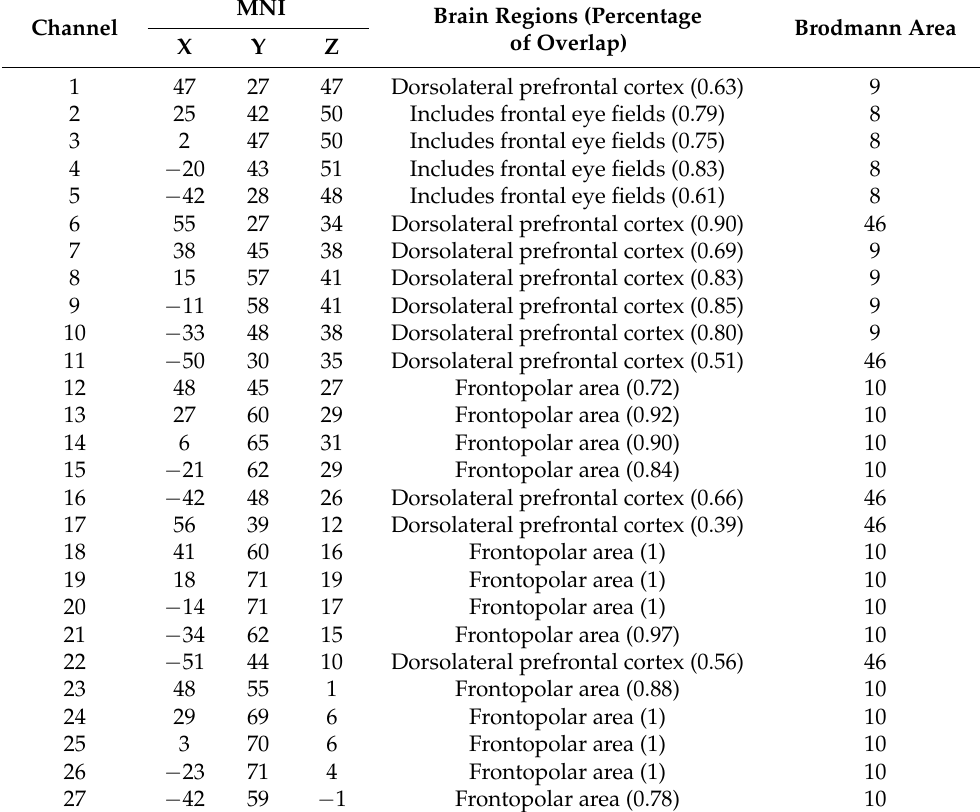
Table 2. The MNI coordinates and anatomical labels corresponding to the 27 measurement